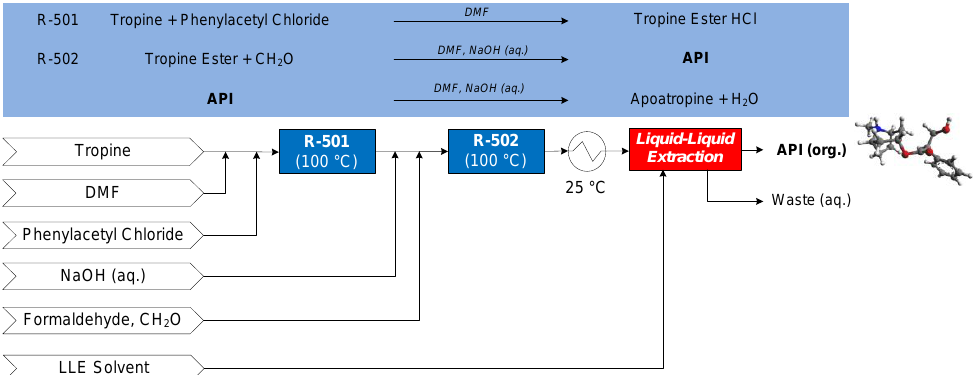
Figure 15. CPM flowsheet for atropine: flow synthesis [69] + continuous LLE [70]. Reproduced with